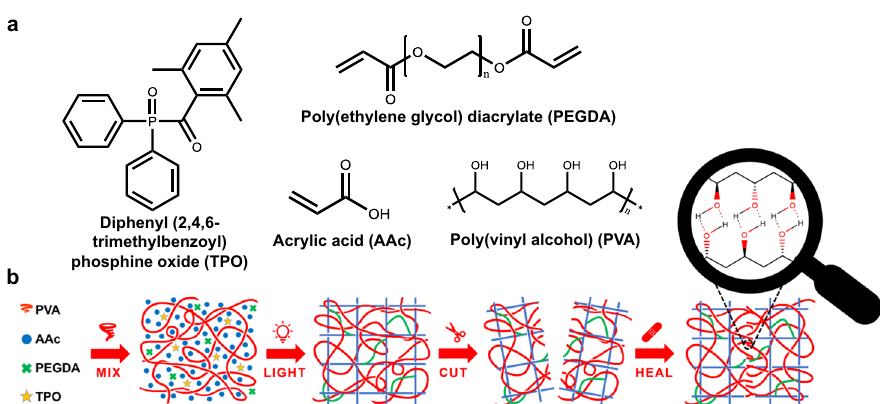
Fig. 1 Formulation composition and network formation. a Chemical structure of initiator, monomer, cross-linker, and mending agent in the photocurable resin. b Schematic illustration of the semi-interpenetrated network (semi-IPN) and